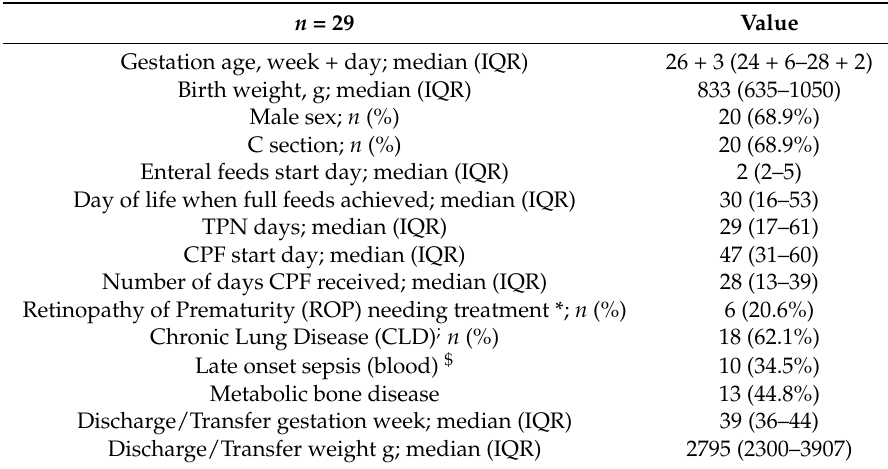
Table 2. Patient characteristics.